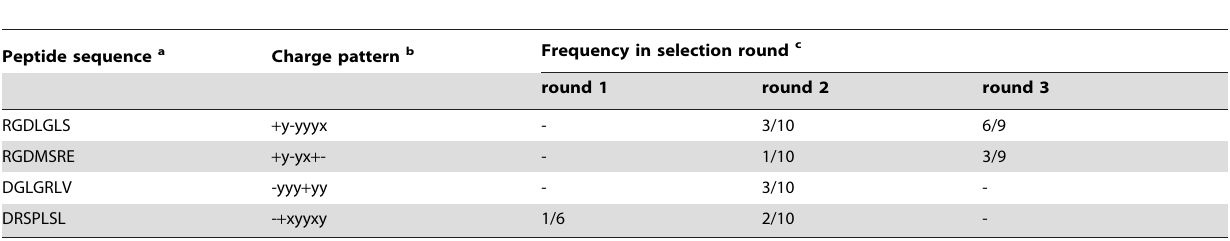
a single letter code; shared amino acid patterns are highlighted in colored letters b charge pattern of amino acid side chains: + , positively charged; 2 negatively charged; x, uncharged polar; y, nonpolar. c observed frequency relative to overall number of sequenced clones doi:10.1371/journal.pone.0005122.t001 PLoS ONE |